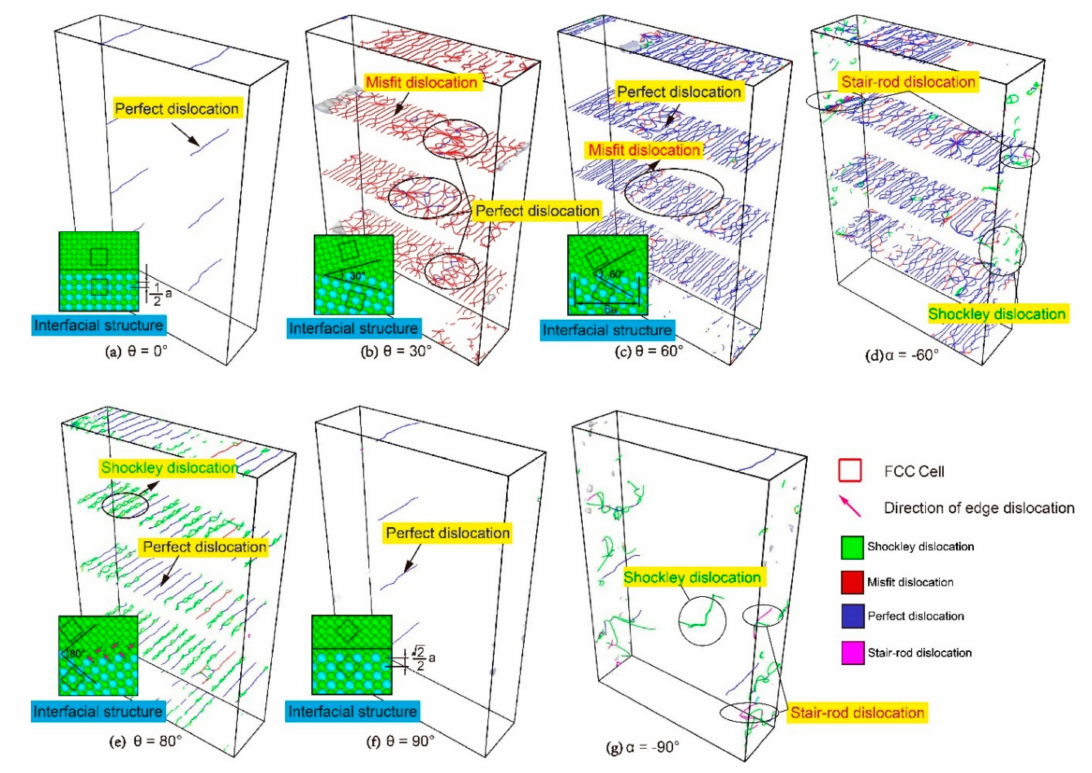
Figure 3. The dislocation analysis (DXA) before the yield point and the structure of the interface with di ff erent misorientations: ( a ) θ = 0 ◦ ; ( b ) θ = 30 ◦ ; ( c ) θ = 60 ◦ ; ( d ) θ = − 60 ◦ ; ( e ) θ = 80 ◦ ; ( f ) α = 90 ◦ ; ( g ) α = − 90 ◦